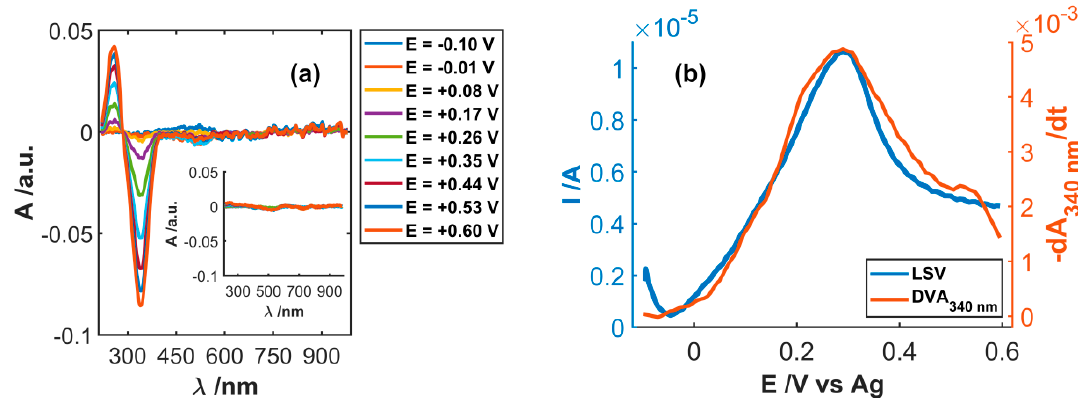
Figure 6. ( a ) Spectra registered during the oxidation of 3·10 − 4 M NADH and 0.1 M PBS. ( b ) Comparison of the linear sweep voltabsorptograms (LSVA) and the derivative voltabsorptogram at 340 nm. Inset in ( a ) shows the spectra registered in 0.1 M PBS.